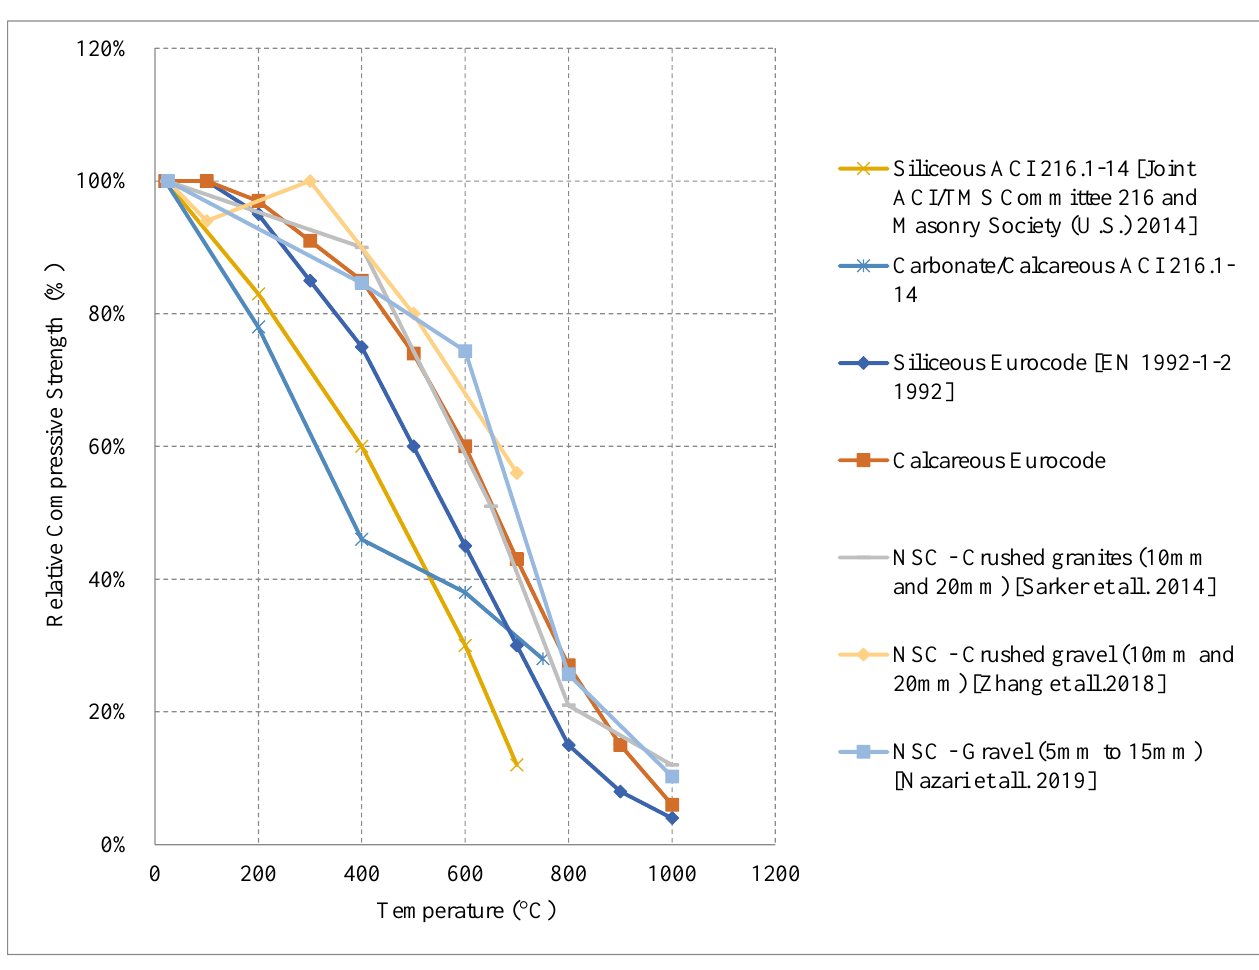
Figure 4. Effect of different constituents on the relative compressive strength of naturally cooled NSC. CR: Cement Replacement, MF: Mass Fraction [35–38].